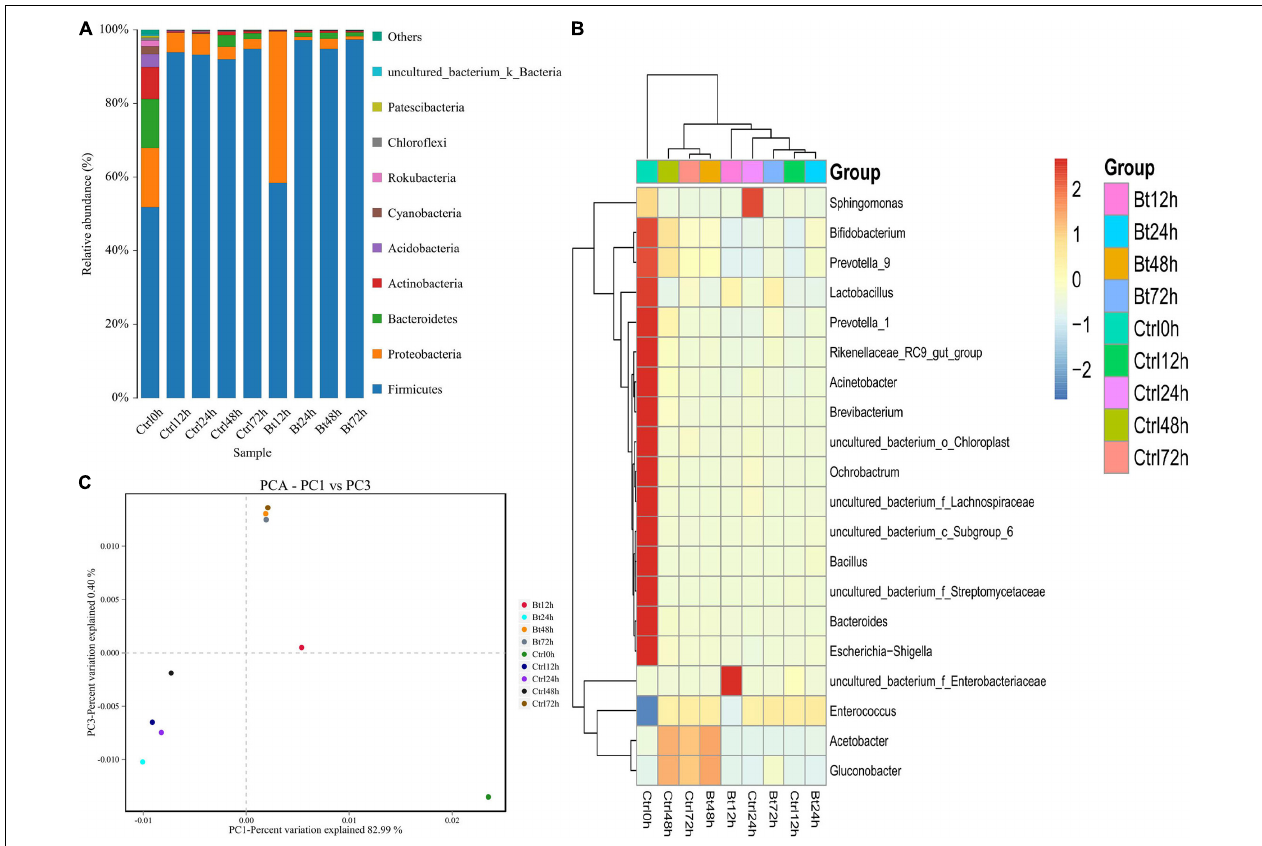
FIGURE 3 | Bt GS57 infection changes in gut microbiota composition in Spodoptera exigua . (A) Histogram showing temporal changes, at the phylum level, in non-infected (Ctrl; ddH